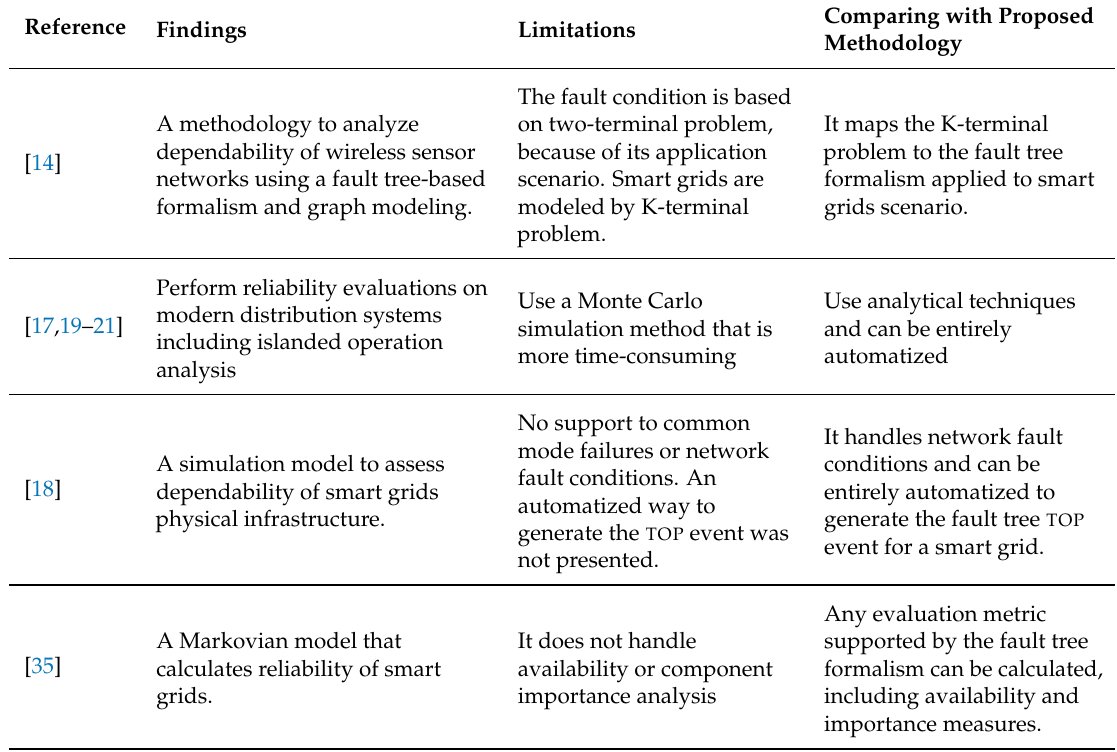
Table 1. Summary of literature reviews closely related with the proposed